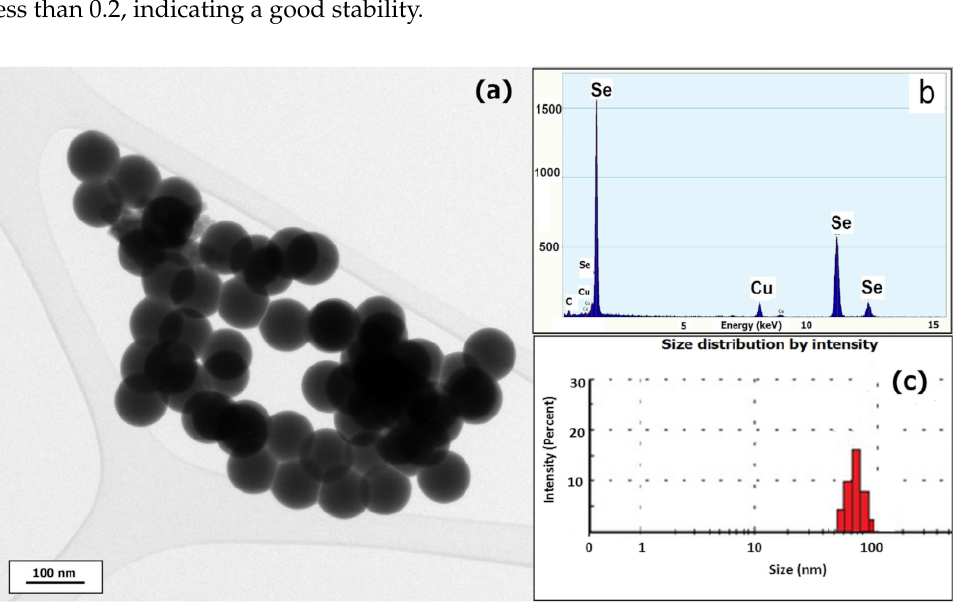
Figure 1. ( a ) TEM micrograph of SeNPs synthesized using L. casei and NaHSeO 3 as a reducing agent; ( b ) energy dispersive X-ray analysis; and ( c ) particles size distribution confirmed by